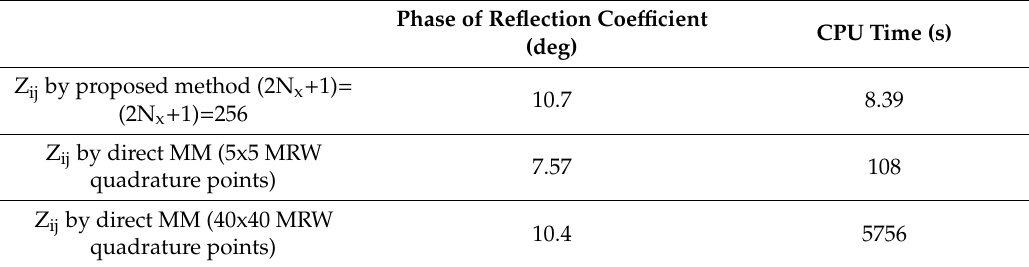
Table 1. At 10 GHz under oblique incidence, θ inc = 20 deg and φ inc = 0 deg with L 1 = 4.1365 mm. The results are shown for direct MM and the proposed method of computation of Z ij .